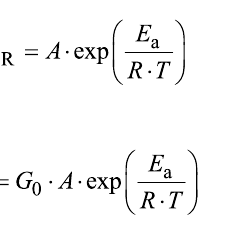
length decreases with increasing temperature according to the